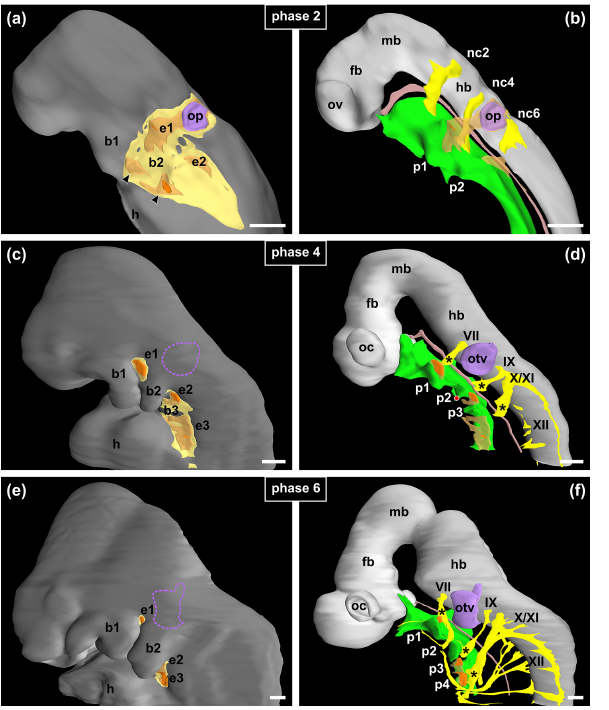
Figure 19. Morphogenesis of the epibranchial placodes and gan- glia in Tupaia belangeri . 3-D reconstructions of 13- to 17-day- old embryos classified according to six phases of ocular devel- opment: surface ectoderm (gray) with three grades of ectodermal thickenings (1: light yellow; 2: light orange; 3: orange), brain (light gray), neural crest streams (yellow), otic anlagen (violet), endoderm (green), and notochord (light brown). (a, c, e) In a rostrocaudal se- quence, three pairs of high-grade thickened epibranchial placodes (e1, e2, e3) develop from a common anlage with the otic placode (op). Arrowheads, presumed hypobranchial placodes; b1, b2, b3; branchial arches 1, 2, 3; h, heart. (b, d, f) Neural crest cells and epibranchial placodes, the latter depending on signals from the pha- ryngeal pouches (p1, p2, p3, p4), contribute glial or neuronal com- ponents to distinct cranial ganglia (asterisks; geniculate ganglion: VII, facial nerve; petrosal ganglion: IX, glossopharyngeal nerve; nodose ganglion: X, vagal nerve). XI, accessory nerve; XII, hy- poglossal nerve; fb, forebrain; hb, hindbrain; mb, midbrain; nc2, nc4, nc6; neural crest streams adjacent to rhombomeres 2, 4, and 6; oc, optic cup; otv, otic vesicle; ov, optic vesicle; red dot, perfora- tion of branchial membrane. Scale bars = 200µm. Reprinted from Washausen et al. (2005, Figs. 2c, d, 4a, b, e, f). © 2004, with per- mission from